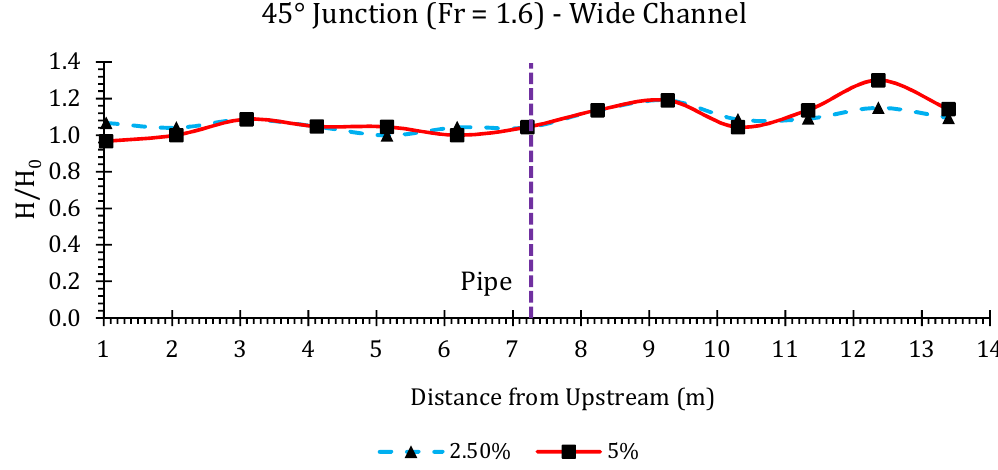
Figure A11. Water height ratios in a 45 ◦ junction for Fr = 1.6 in the wide Figure A11. Water height ratios in a 45° junction for Fr = 1.6 in the wide channel. Figure A11. Water height ratios in a 45° junction for Fr = 1.6 in the wide channel. Figure A11. Water height ratios in a 45° junction for Fr = 1.6 in the wide channel.